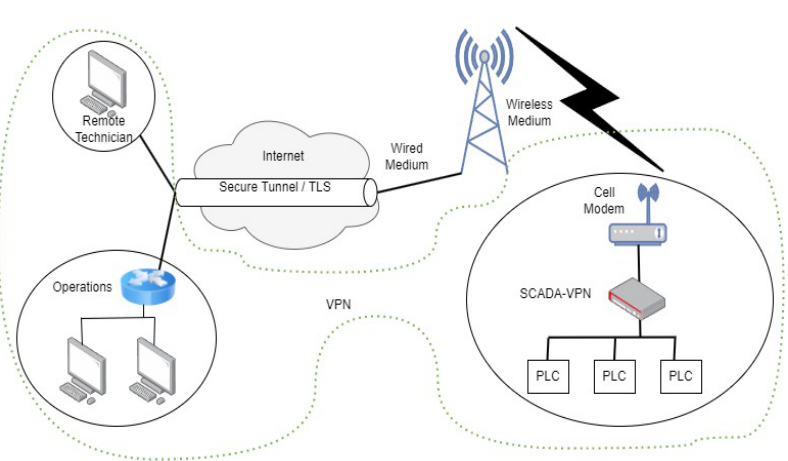
Figure 6. A proxy for protection against network and transport layer DDoS attacks.